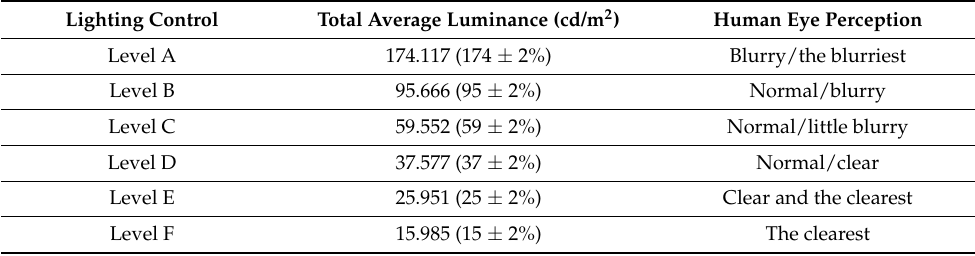
Table 7. Clarity evaluation of various lighting control in case